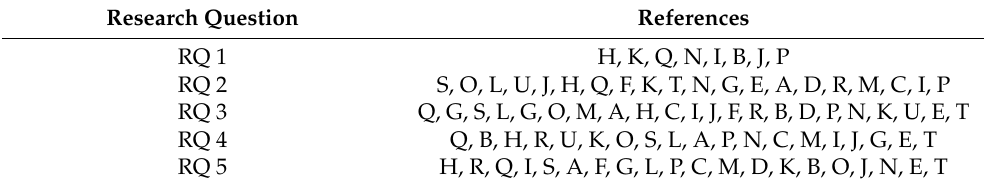
Table A2. Summary table for Discussion